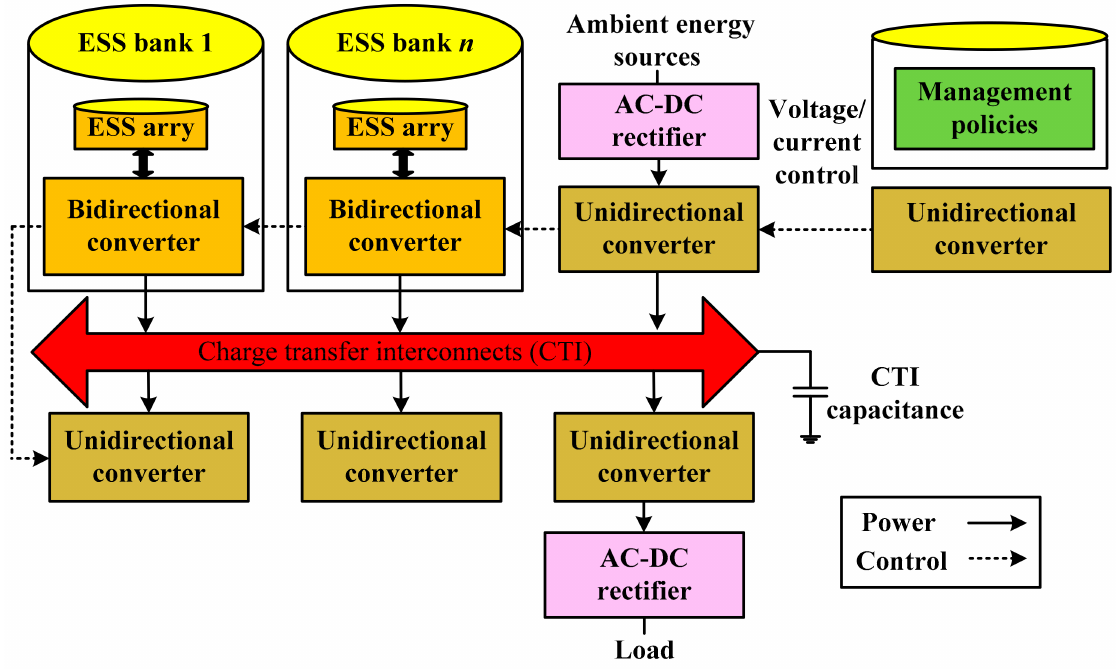
Figure 15. Generalized architecture of hybrid energy storage